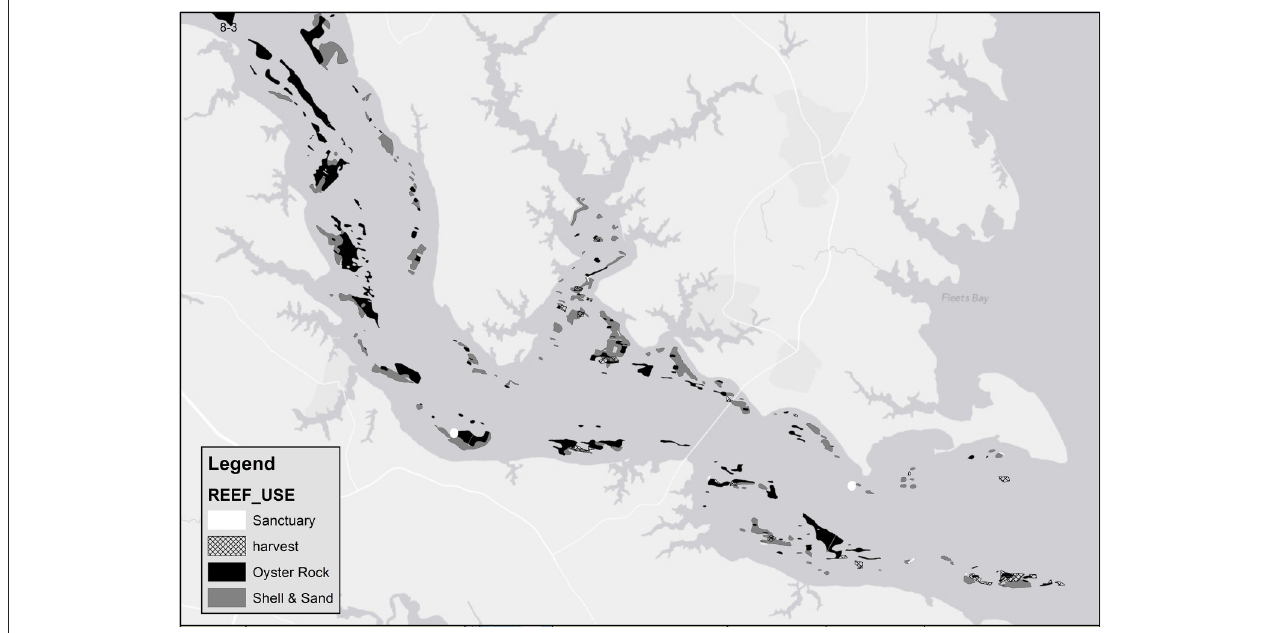
FIGURE 5 | Shell placement in the Rappahanock River, early 2000’s. Note a large portion of the shells were not placed on the highest quality “oyster rock” bottom areas.